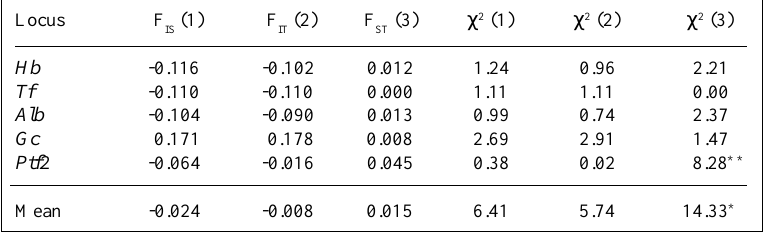
Table III - Estimated F-statistics per locus in the “Alberes” cattle breed, and their statistical significances (chi-square tests). (1) Locus F IS